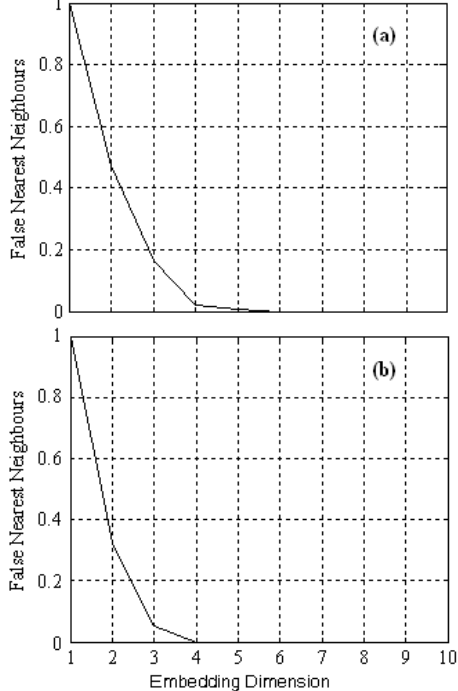
Figure 6. The fraction of false nearest neighbors versus the embedding dimension for (a) Wind speed, (b) Wind power time